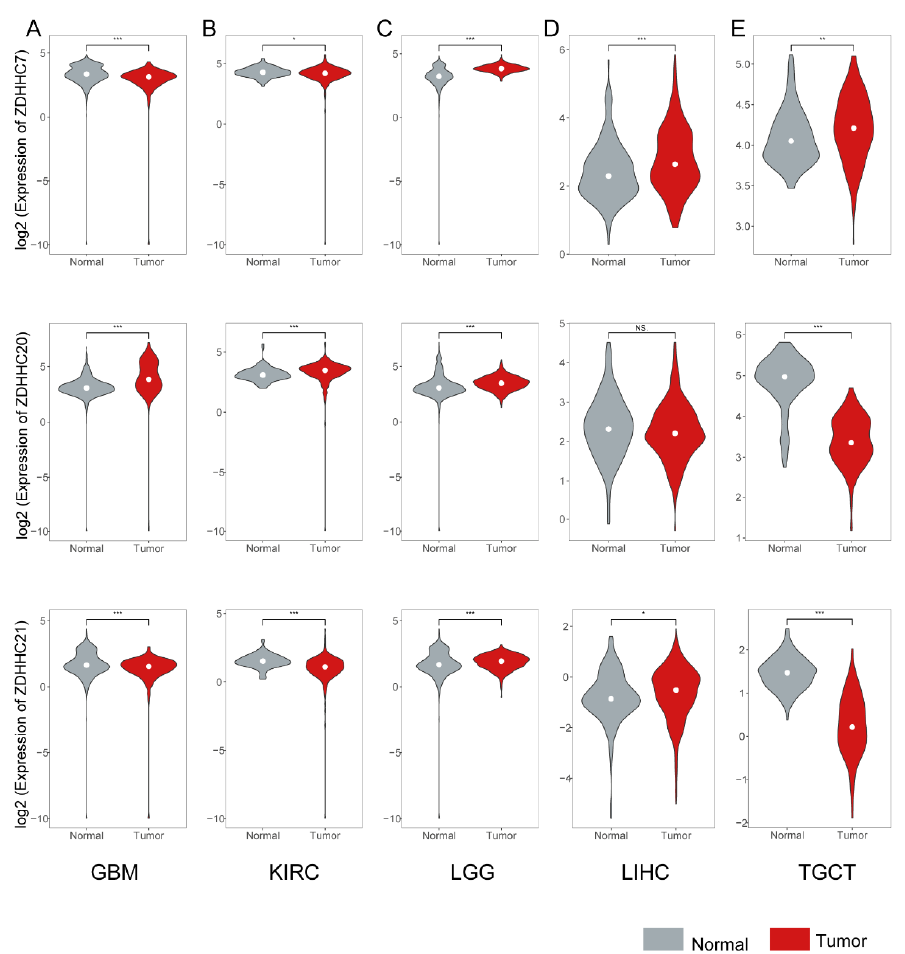
Figure 3. Violin plots exhibiting the expression of ZDHHC7/20/21 in tumor and normal samples. ( A ) Expression of ZDHHC7/20/21 in GBM. ( B ) Expression of ZDHHC7/20/21 in KIRC. ( C ) Expression of ZDHHC7/20/21 in LGG. ( D ) Expression of ZDHHC7/20/21 in LIHC. ( E ) Expression of ZDHHC7/20/21 in TGCT. * indicates p < 0.05. ** indicates p < 0.01. *** indicates p < 0.001. “NS.” represents no significance. A white dot represents the “median”